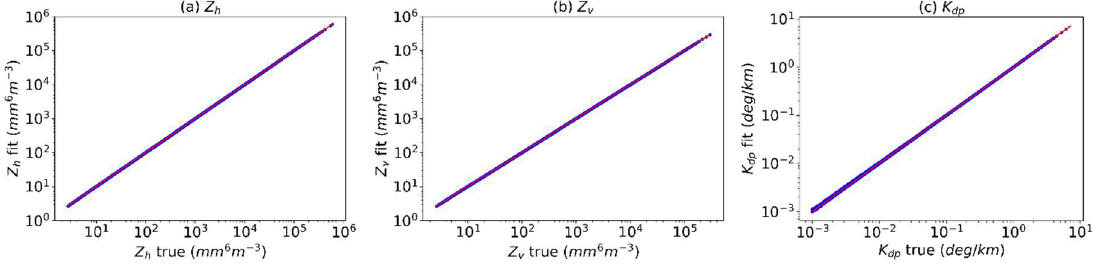
Figure 4. Scatterplots of the polarimetric variables calculated via an integral equation (abscissa axis) and via polynomial fitted relation (ordinate axis): ( a ) Z h ; ( b ) Z v ; and ( c ) K dp . The red line is a reference for the abscissa axis equal to the ordinate axis.